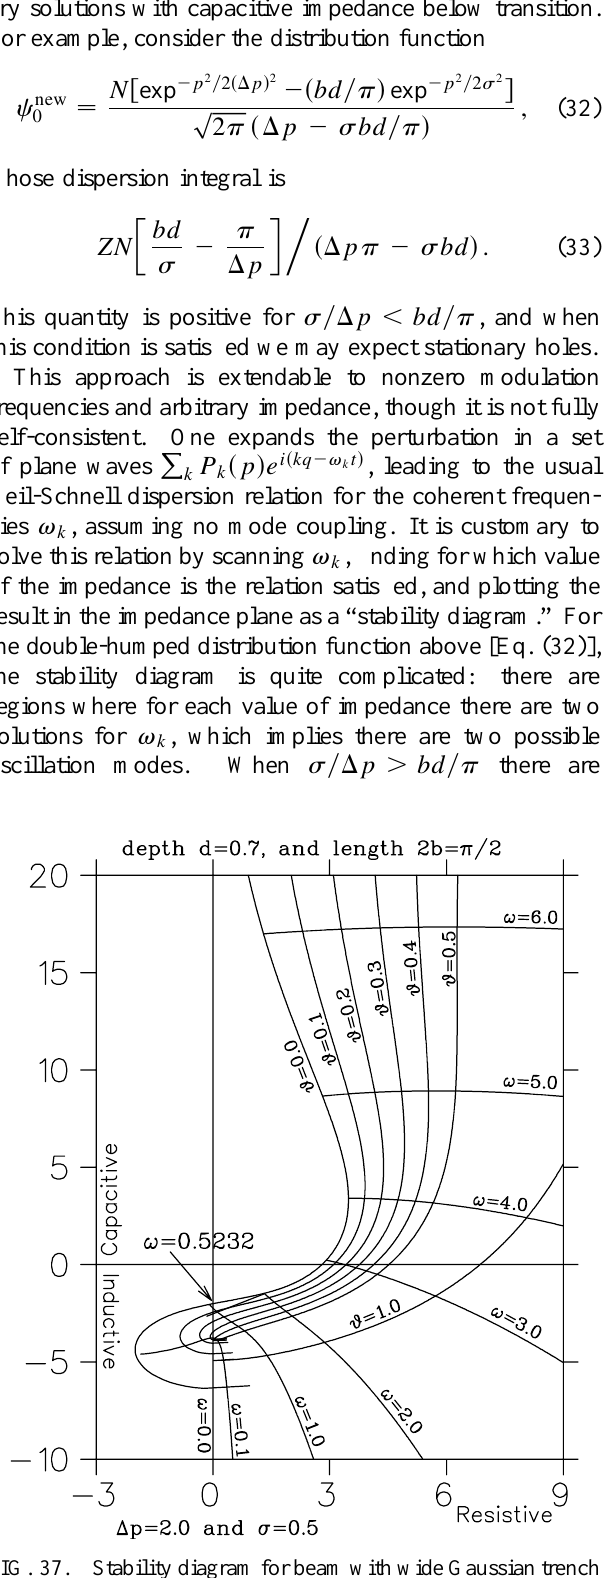
FIG. 37. Stability diagram for beam with wide Gaussian trench s (cid:3) D p . bd (cid:3) p (cid:1) s (cid:3) D p (cid:1) 0.25 (cid:2) .